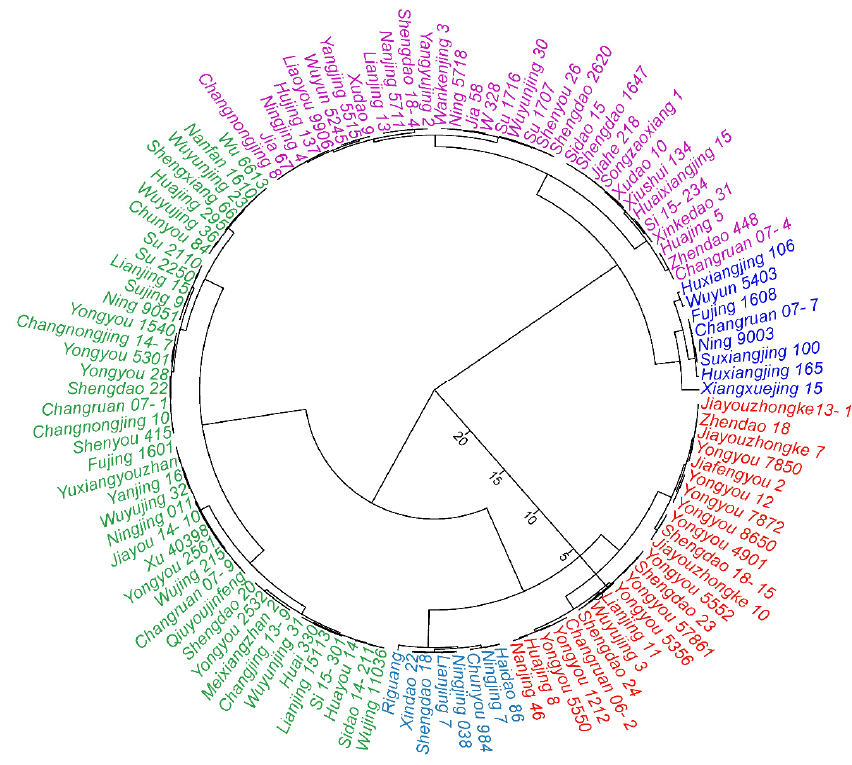
Figure 2. Hierarchical cluster analysis based on the D-value, Euclidean distance, and Ward’s al- gorithm were used to evaluate the salt tolerance of 114 rice germplasms. As shown in the figure, highly salt-tolerant varieties are blue in color; red color represents salt-tolerant varieties; green color represents moderately salt-tolerant varieties; magenta color represents salt-sensitive varieties; and blue color represents highly salt-sensitive varieties.